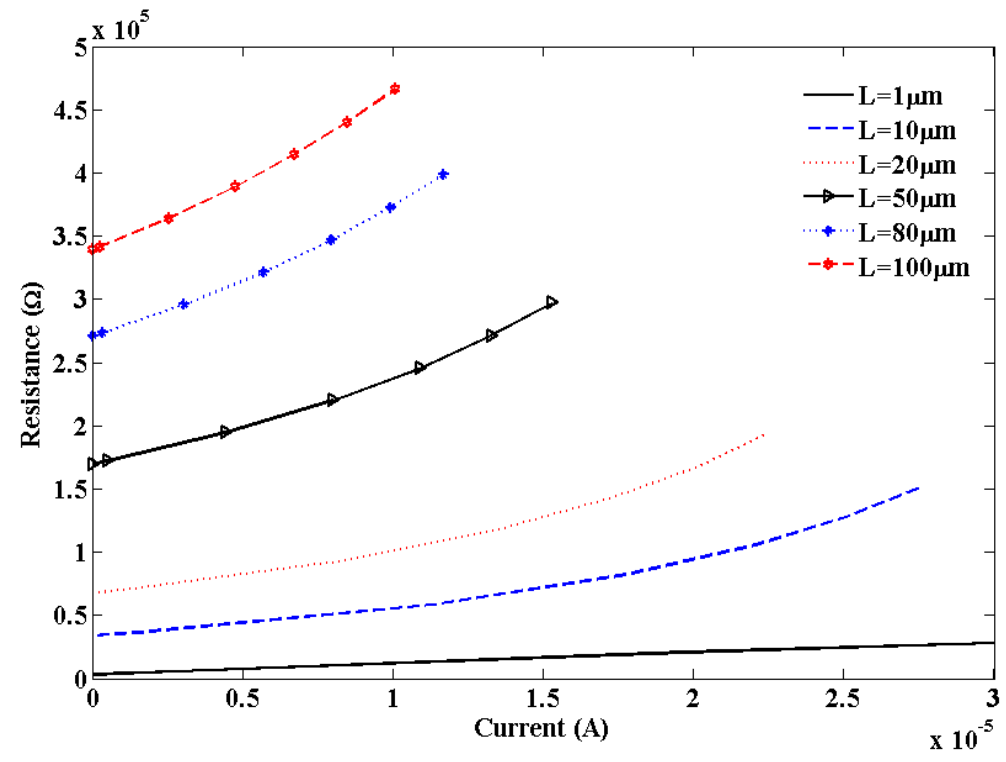
Figure 7. Plot of SWCNT resistance versus current.